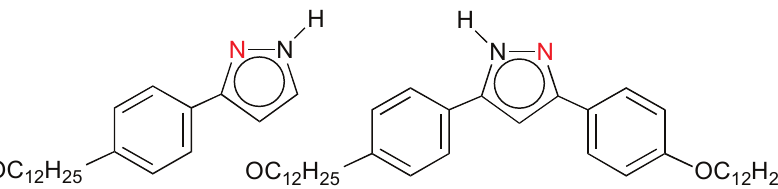
Figure 23. Mono and disubstituted pyrazole ligands.